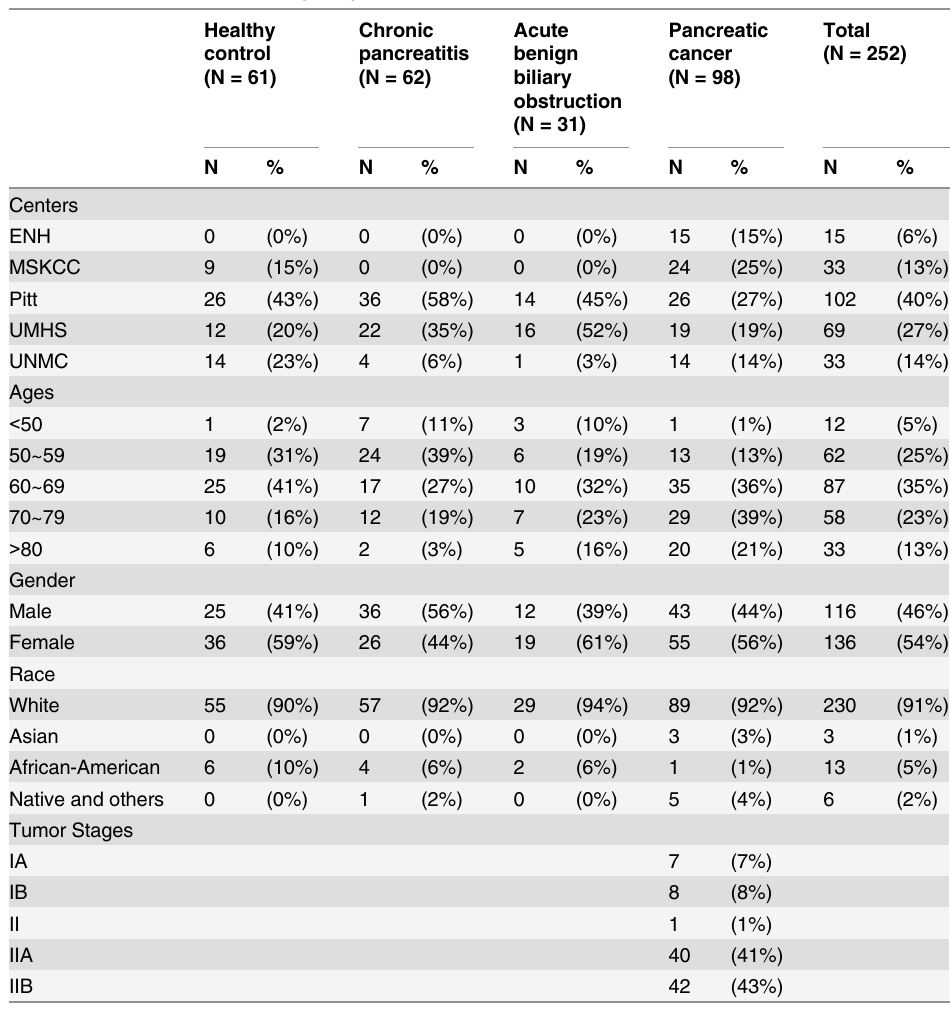
Table 1. Characteristics of study